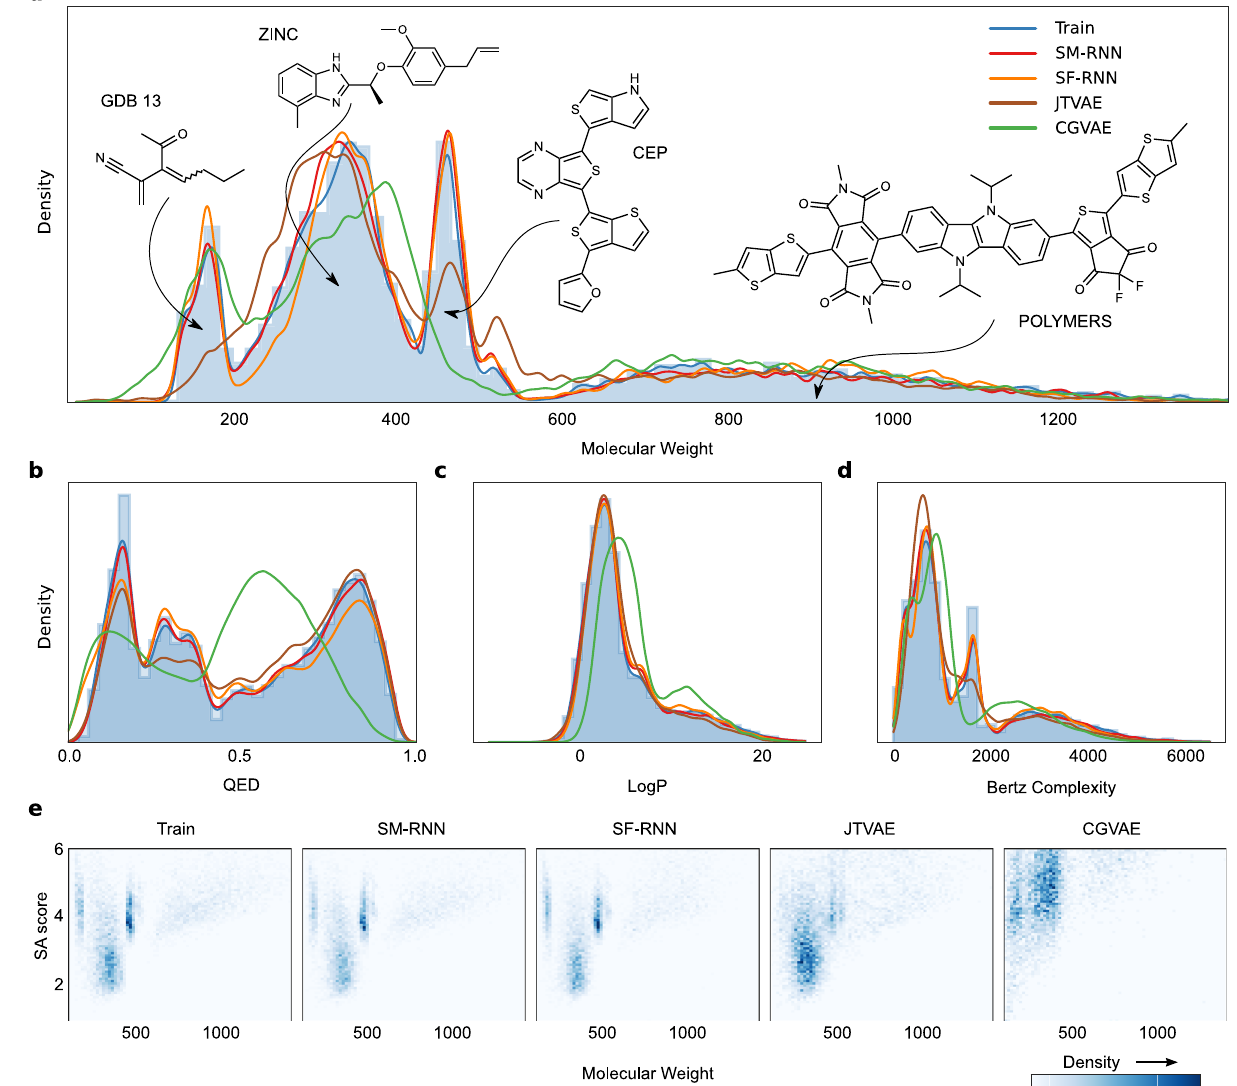
Fig. 4 Multi-distribution Task. a The histogram and KDE of molecular weight of training molecules along with KDEs of molecular weight of molecules generated from all models. Three training molecules from each mode are shown. b – d The histogram and KDE of QED, LogP and SA scores of training molecules along with KDES of molecules generated from all models. e 2d histograms of molecular weight and SA score of training molecules and molecules generated by all